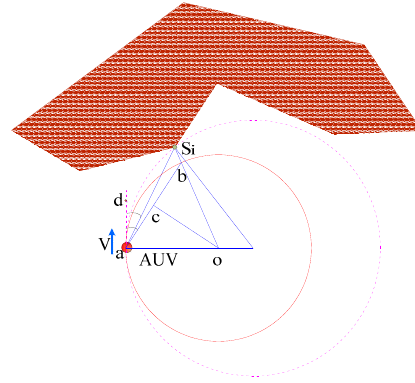
Figure 3. Desirable maximum turning radius for an arbitrary detection point.